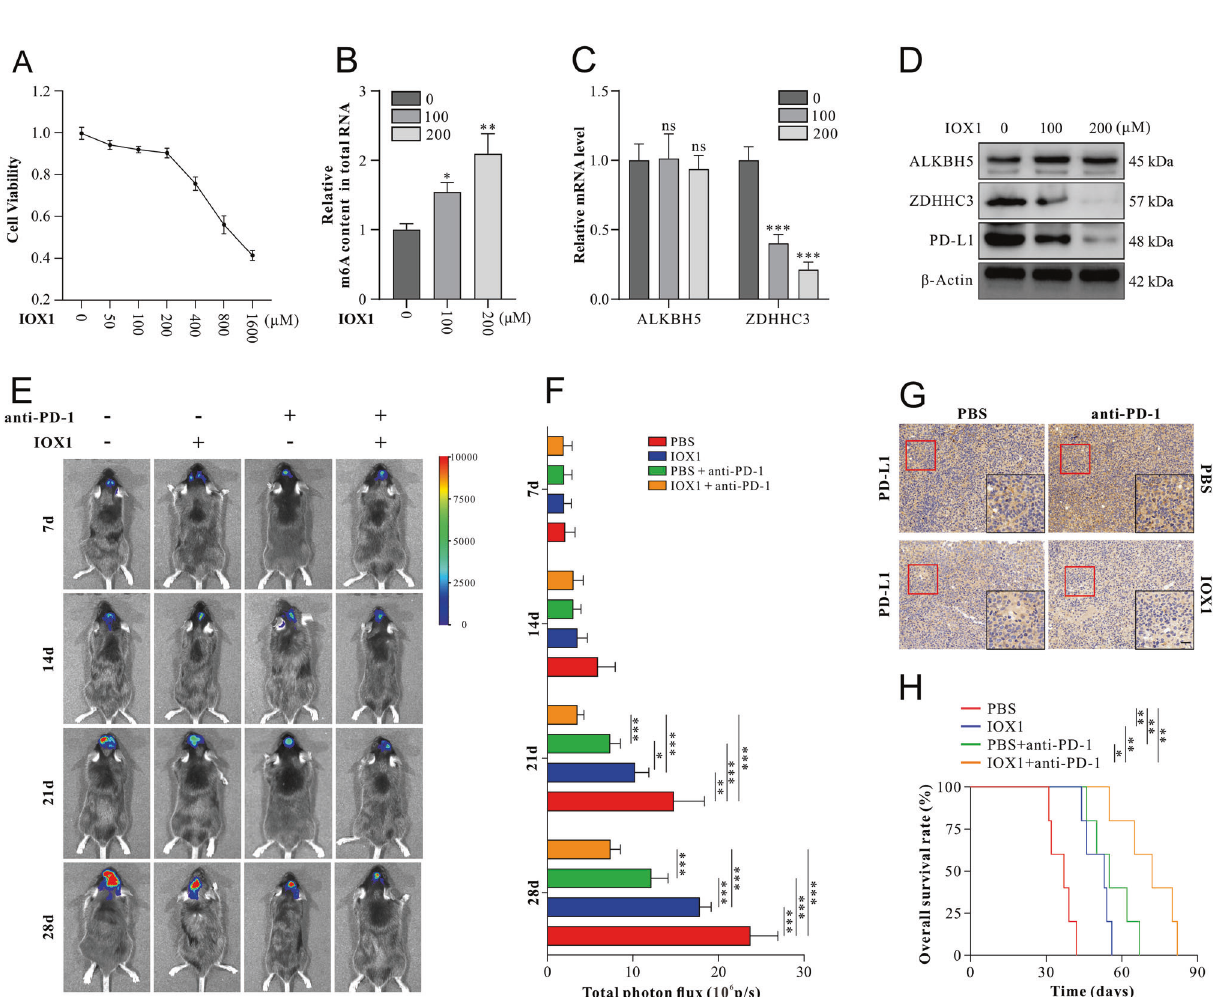
Fig. 7 An ALKBH5 inhibitor IOX1 improves the ef fi cacy of anti-PD-1 therapy in GBM mice model. A Proliferation assays of U87 cells treated with DMSO control, 50 μ M, 100 μ M, 200 μ M, 400 μ M, 800 μ M, or 1600 μ M IOX1. B M6A quanti fi cation assays evaluated the relative enrichment of m6A methylation of total RNA in U87 cells treated with DMSO control, 100 μ M, and 200 μ M IOX1, respectively. C Relative expression of ALKBH5 and ZDHHC3 mRNA was measured by qRT-PCR in U87 cells treated with DMSO control, 100 μ M, and 200 μ M IOX1, respectively. D ALKBH5, ZDHHC3, and PD-L1 protein expression were detected by western blot in U87 cells treated with DMSO control, 100 μ M, and 200 μ M IOX1, respectively. E Representative pseudocolor bioluminescence images of GBM-bearing C57 mice on days 7, 14, 21, and 28 after GL261 cells were implanted (day 0). GBM-bearing mice have injected with anti-PD-1 Ab (at a dose of 5 mg/kg) on day 10, day 15, and day 20 with or without intraperitoneal injection of IOX1 (at a dose of 10 mg per kilogram of mice weight) on day 5, day 7, and day 9. F Quanti fi cation of tumor-associated bioluminescence radiance intensity with data presented as mean ± SD. G PD-L1 expression was measured by immunohistochemical staining in GBM tissues isolated from mice treated with IOX1 and anti-PD-1 therapy. H The Kaplan – Meier curve analyzed overall survival in GBM-bearing mice treated with IOX1 and/or anti-PD-1. Scale bar = 60 μ m. Data are presented as mean ± SD. n = 8 per group. * p < 0.05, ** p < 0.01, *** p <